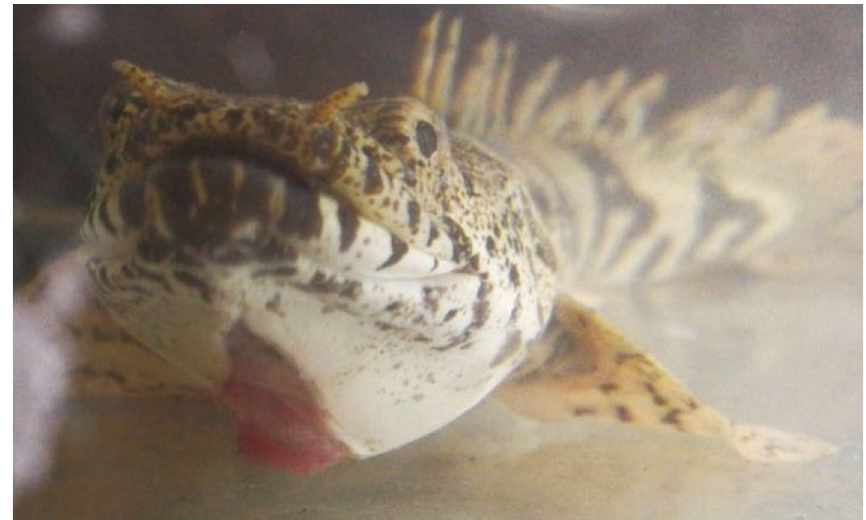
Figure 1: Mass in the gular region of a saddled bichir ( Polypterus endlicheri endlicheri ) on fi rst observation.